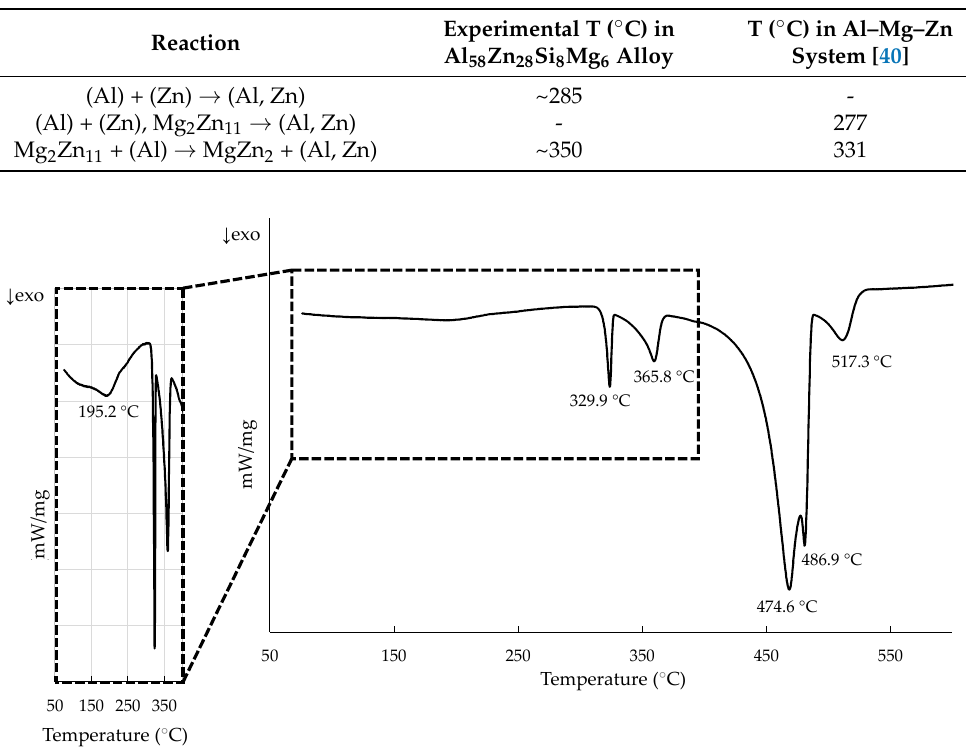
Figure 11. DSC curve for the as-cast sample during cooling. Compressed graph to highlight possible peak showing Zn phase precipitation.